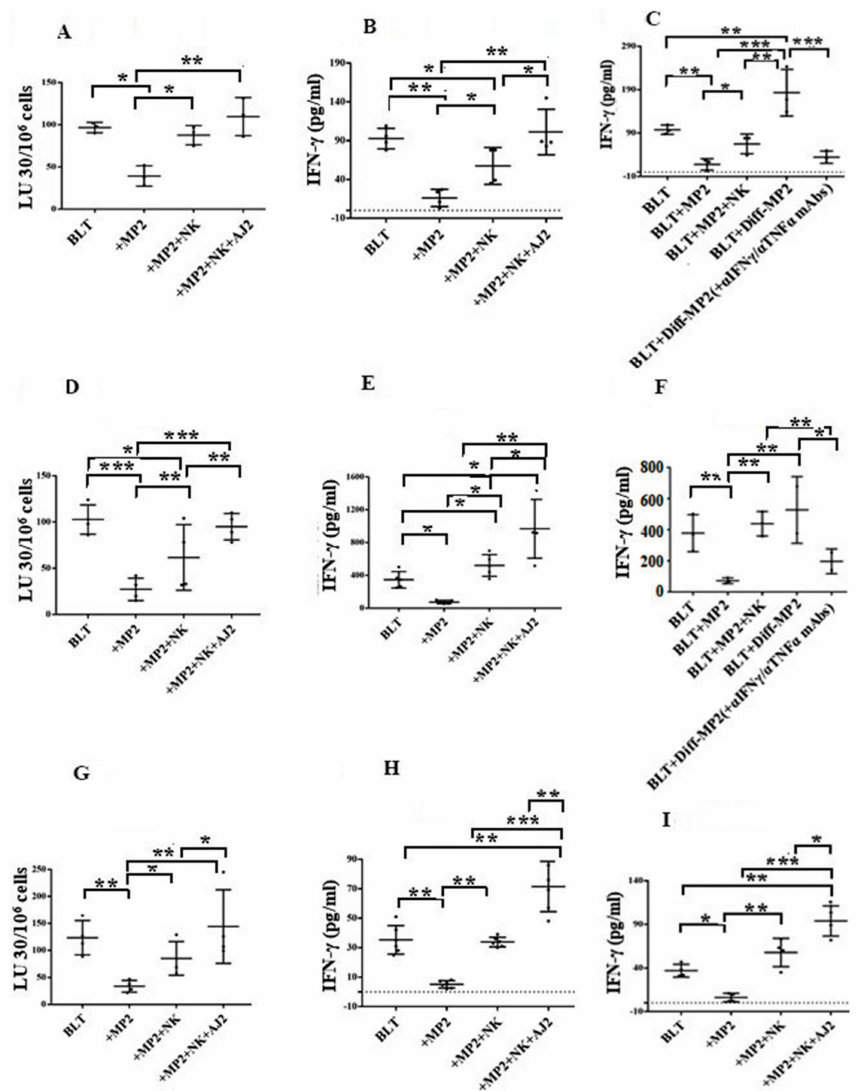
(Figure 5). Blocking NK di ff erentiation of the tumors by anti-IFN- γ and anti-TNF- α antibodies resulted in a similar magnitude of IFN- γ secretion to those obtained from undi ff erentiated tumors in all tissue compartments tested (Figure